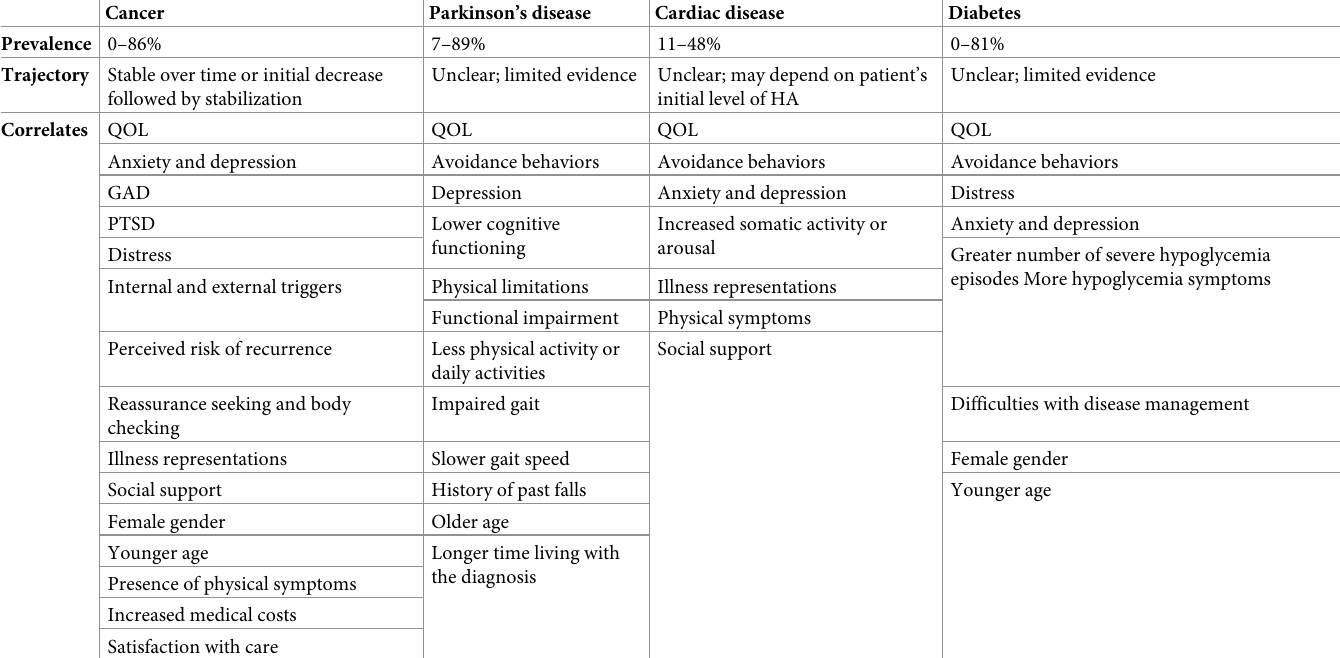
Table 6. Summary of main findings on prevalence, trajectory, and correlates of health anxiety among the four most frequent chronic